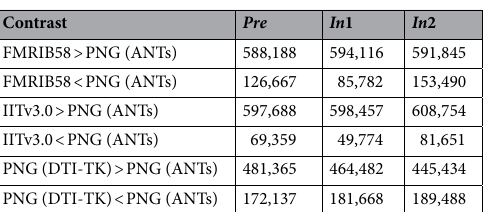
Table 1. Number of statistically significant ( p < 0.05, FWE corrected) voxels of potential bias when normalizing the FA maps of 64 high school varsity football athletes to the PNG (ANTs) DTI template and to the other templates. Comparisons at multiple sessions ( Pre , In 1, In 2) are presented. For illustrations of the voxel-wise t -statistical maps, see Supplementary Fig. S1 online.